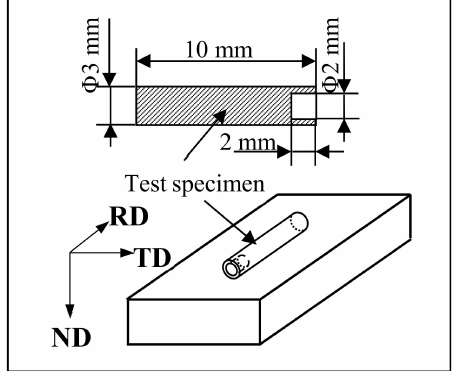
Figure 1. Specimen geometry for thermal expansion testing.